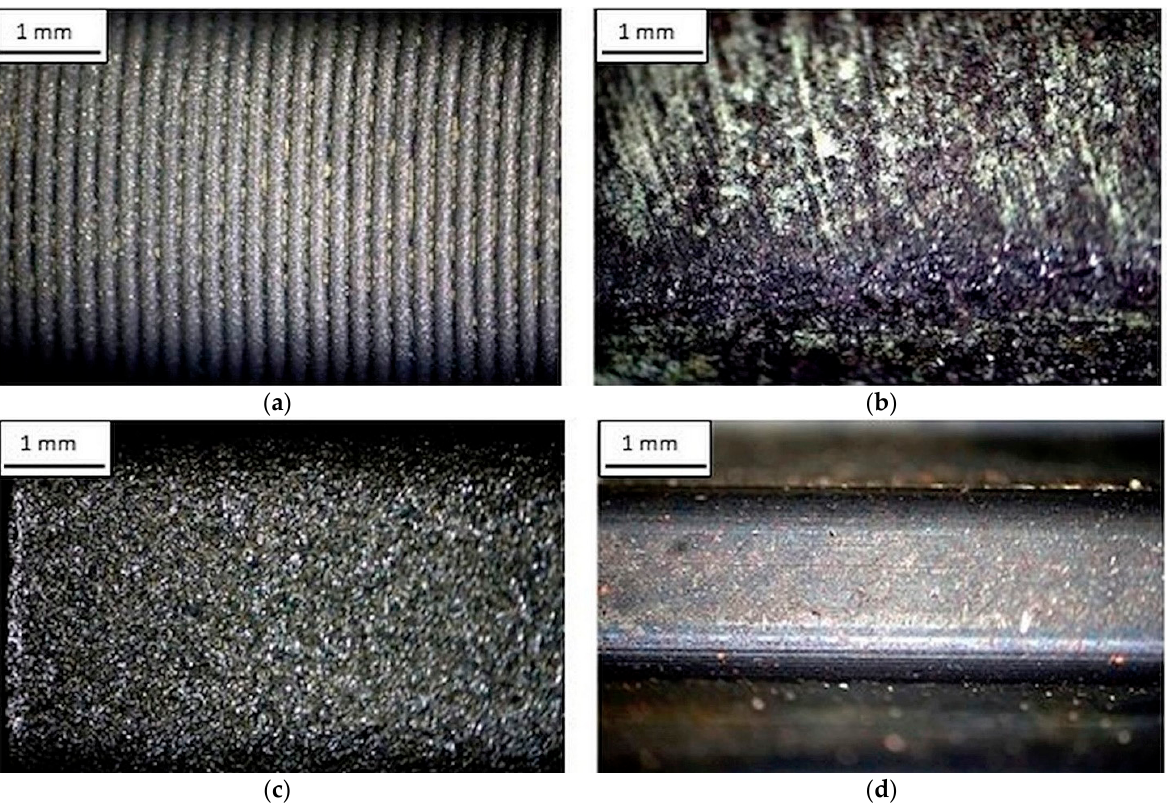
Figure 5. Optical light microscopy images of the wheels surface manufactured with the use of various technologies: ( a ) FDM, ( b ) 3DP Z corporation, ( c ) SLS and ( d ) wheel made of C45E steel with a geometry similar to the circle produced by machining.